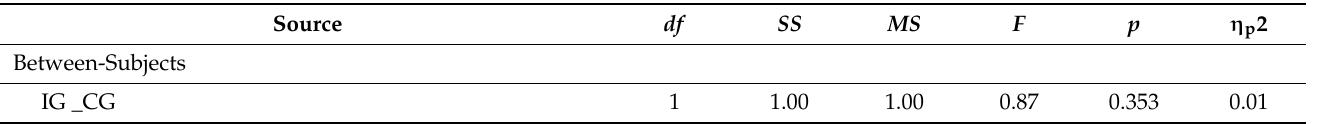
Table 4. MANCOVA